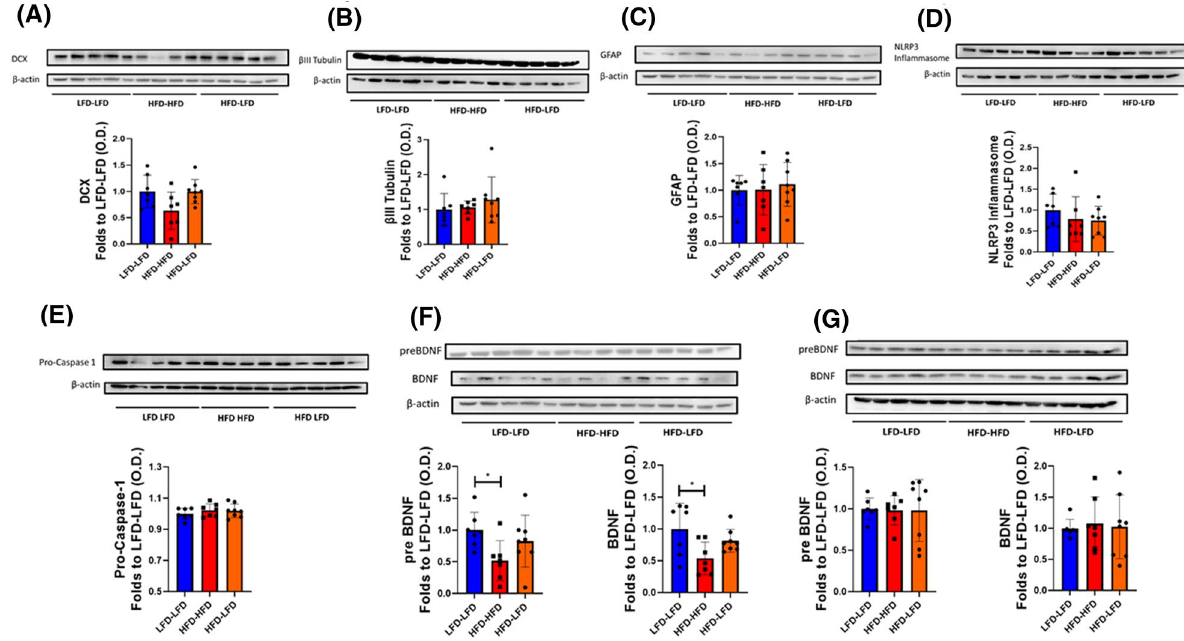
Figure 6. Biochemical changes associated with HFD in dorsal and ventral hippocampus. DCX ( A ), β III Tubulin ( B ), GFAP ( C ), NLRP3 Inflammasome ( D ), Pro-Caspase 1 ( E ) and BDNF ( F ) western blot analysis of the dorsal hippocampus of animals fed for 14 days with HFD (Red) or LFD (Blue) or for 7 days with HFD followed by 7 days with LFD (Orange) starting from the fifth week of age (n = 7 LFD-LFD, n = 7 HFD-HFD, n = 8 HFD-LFD). BDNF ( G ) western blot analysis of the ventral hippocampus of animals fed for 14 days with HFD (Red) or LFD (Blue) or for 7 days with HFD followed by 7 days with LFD (Orange) starting from the fifth week of age (n = 7 LFD-LFD, n = 7 HFD-HFD, n = 8 HFD-LFD). Bands shown are representative. Data are presented as mean ± SD and a single dot represent the result from one animal. *p < 0.05, One-way ANOVA with Tukey’s post-hoc test. Full-length blots are presented in Supplementary Figs. S5–S12. GraphPad Prism 8 (https:// www. graph pad. com/) and Power Point were used to generate the